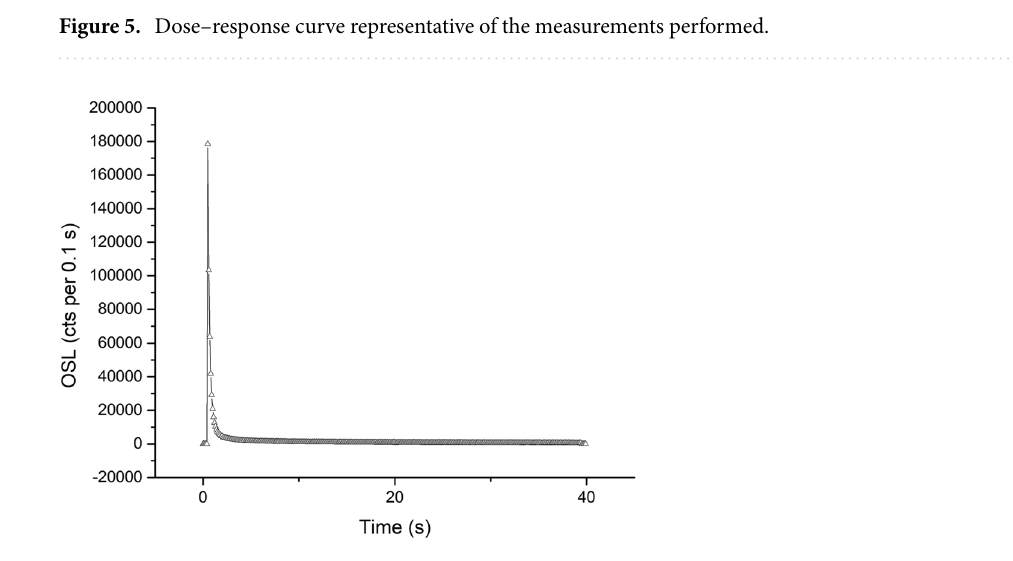
Figure 6. OSL decay curve representative of the measurements